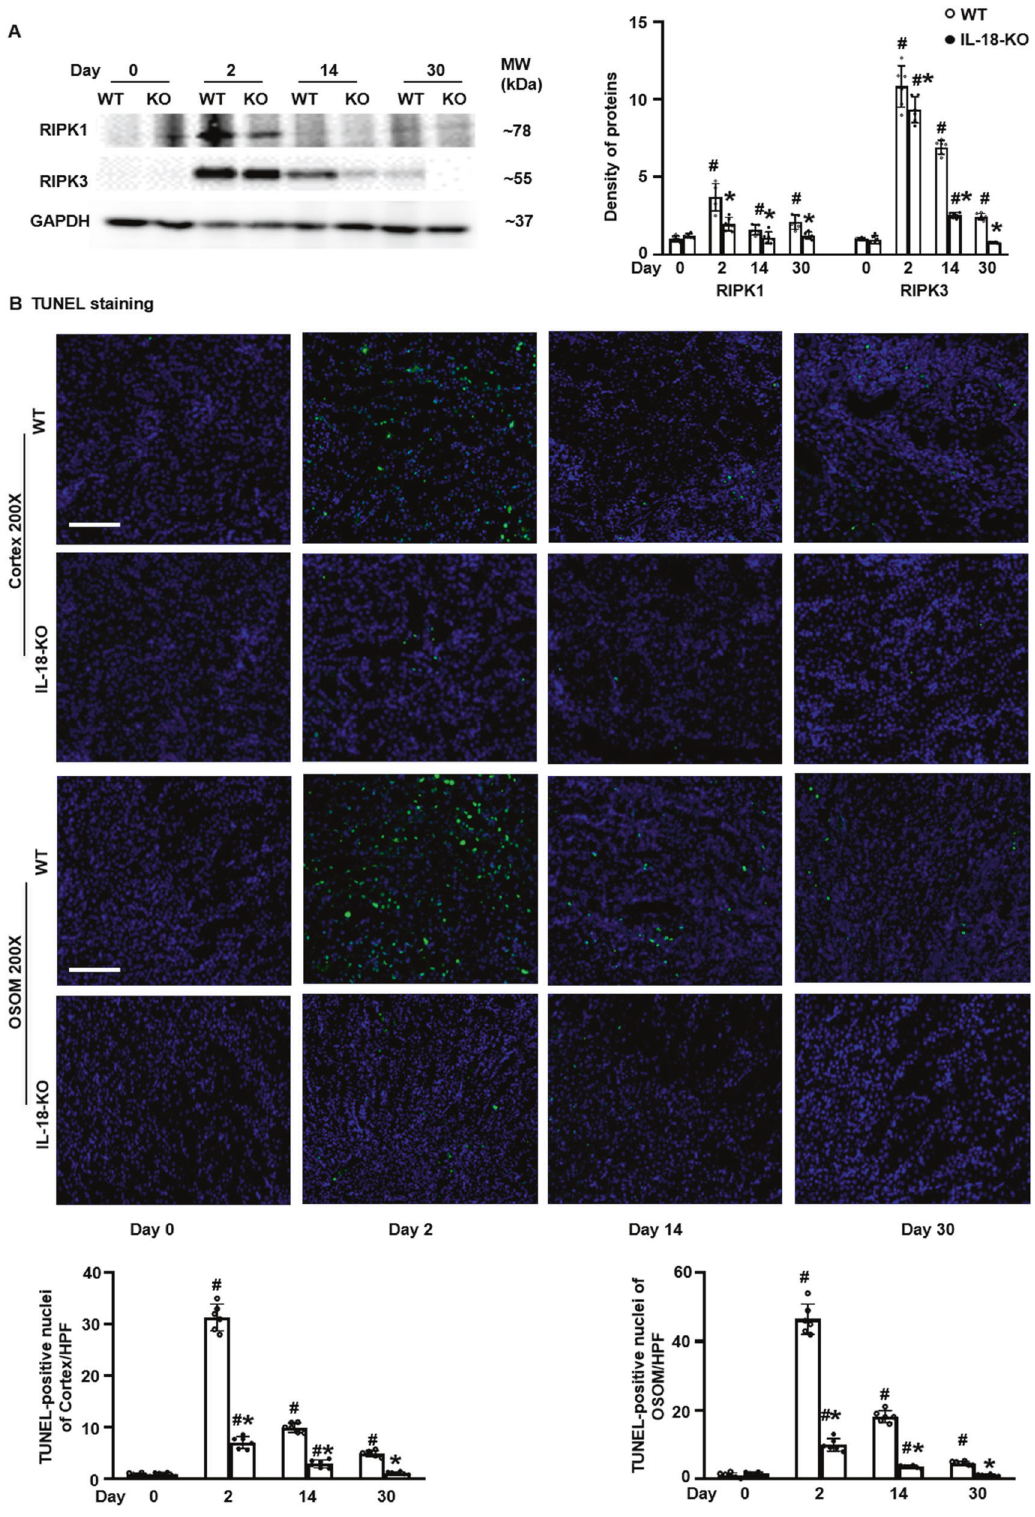
Fig. 2 IL-18 deletion ameliorated renal necroptosis in folic acid-injected mice. A Renal protein expression of RIPK1 and RIPK3, two necroptosis biomarkers, peaked at day 2, analyzed by Western blotting and the density of the blots. B TUNEL staining and semi- quantitative analysis in renal cortex and outstrip of outer medulla (OSOM). Magni fi cation, 200× bar = 100 um. Data represent Mean ± SD ( n = 6, # p < 0.05, other groups vs. day 0; * p < 0.05, KO vs. WT).